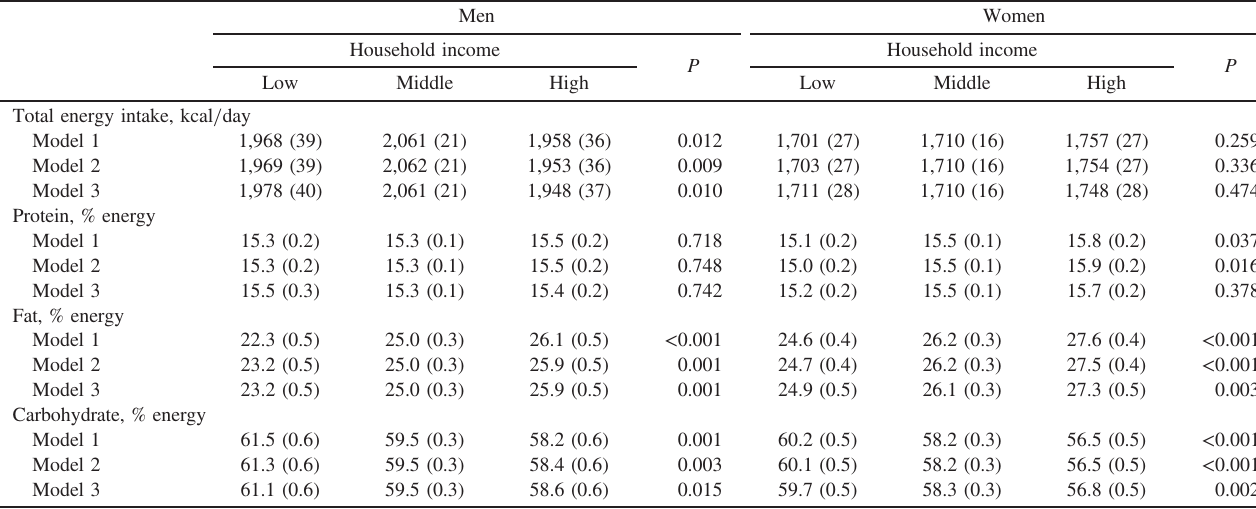
Table 3. Adjusted intakes of macronutrients according to household income: NIPPON DATA2010 Men Women